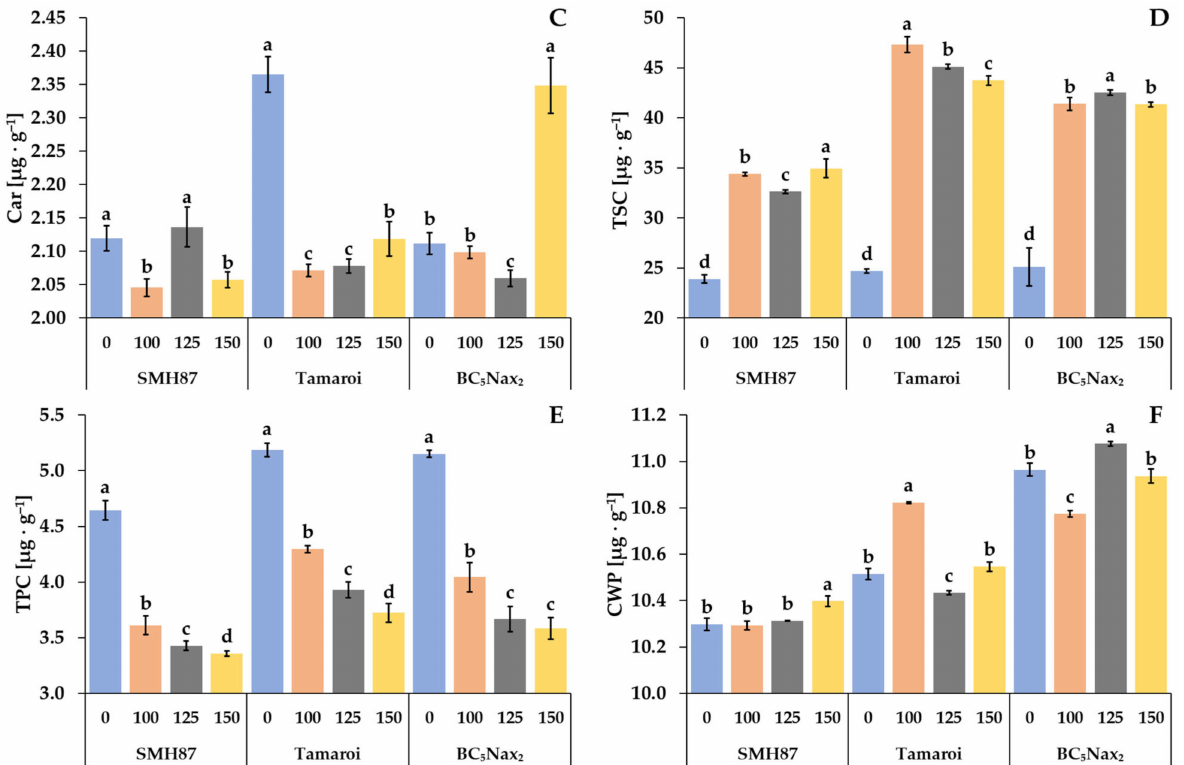
Figure 5. Effects of NaCl treatments (0, 100, 125, 150 mM) on Chl a —chlorophyll a ( A ), Chl b — chlorophyll b ( B ), Car—carotenoids ( C ), TSC—total soluble carbohydrates ( D ), TPC—total phenolic compounds ( E ), CWP—cell wall-bound phenolics ( F ). The values represent means (n = 3) ± SE within each accession, and those marked with the same letters do not differ statistically according to